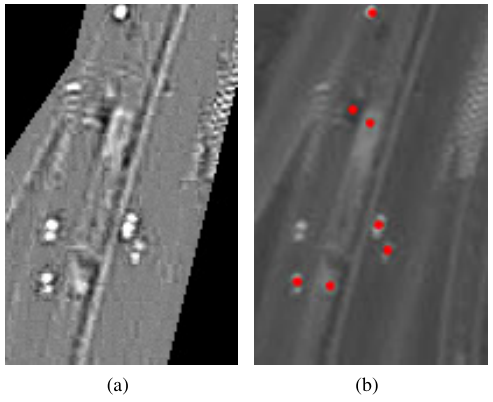
Figure 16: Illustration of local result.(a)Texture image. (b)Vehicle detection result is marked by red point, object located on lane center is mistakenly detected.